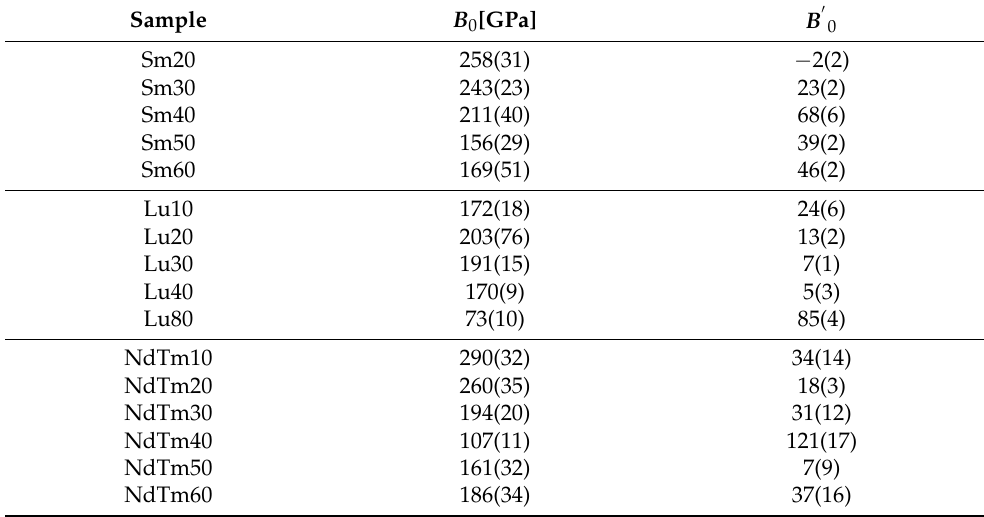
Table 1. B 0 and B (cid:48) 0 values obtained from the refinement of the third order Rose-Vinet equation of state applied to the three studied